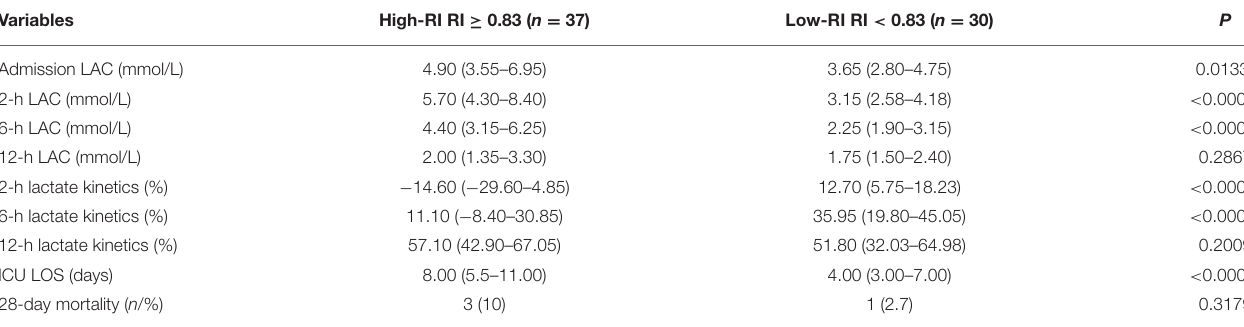
TABLE 5 | Lactate concentrations and kinetic changes between the high and low resistance index groups.